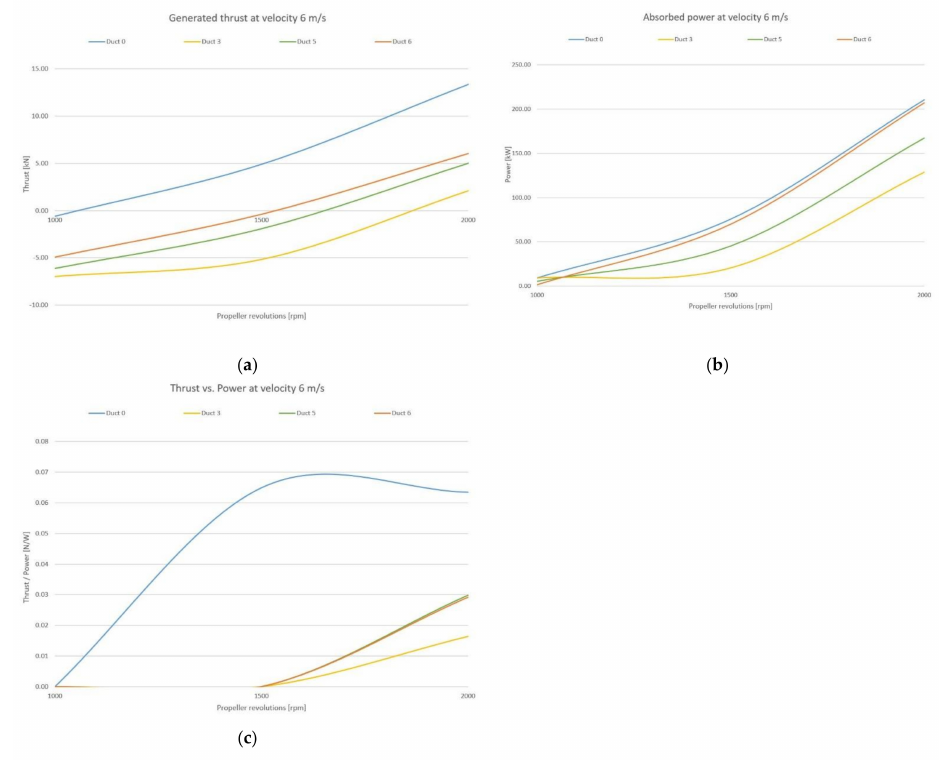
Figure 9. Comparison of parameters for flow velocity 6 m/s. ( a ) Generated thrust at velocity 6 m/s;